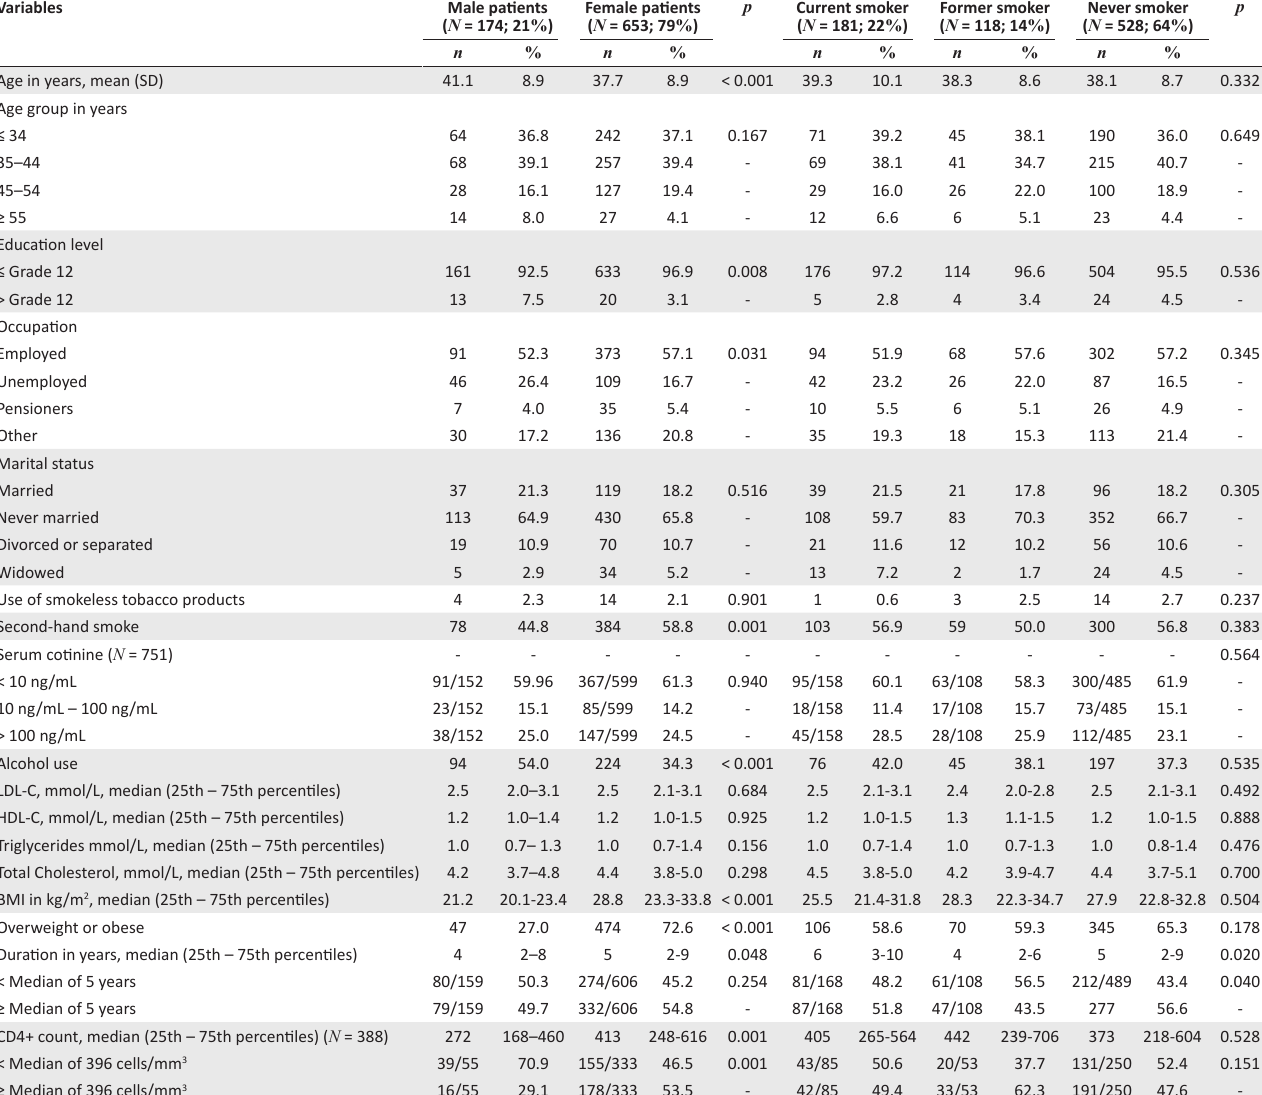
TABLE 1: Characteristics of human immunodeficiency virus patients presented by gender and smoking status.